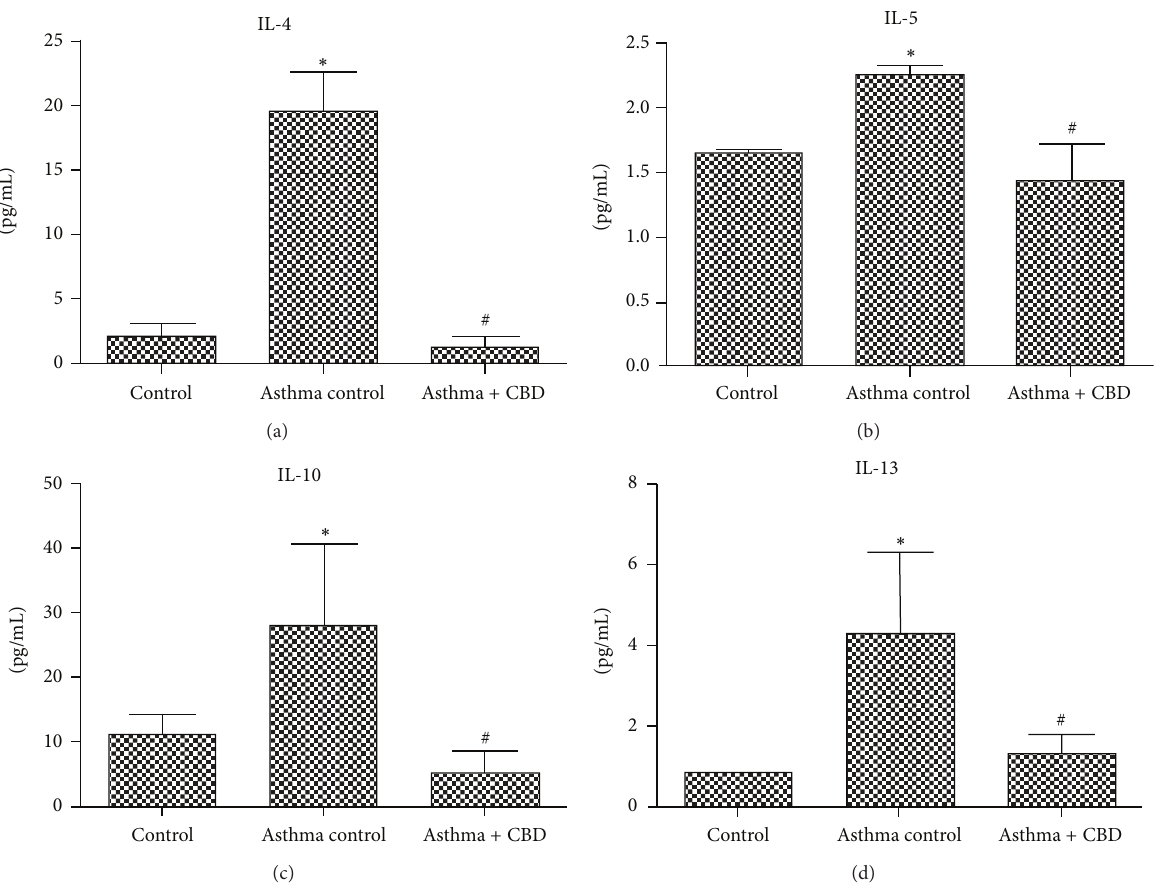
Figure 2: Effects of cannabidiol on Th2 profile cytokine levels. (a) IL-4 levels. (b) IL-5 levels. (c) IL-10 levels. (d) IL-13 levels. Bars represent means ± SD of 7 rats. ∗ 𝑝 < 0.05 versus control vehicle, # 𝑝 < 0.05 versus asthma control. ANOVA and post hoc Newman-Keuls